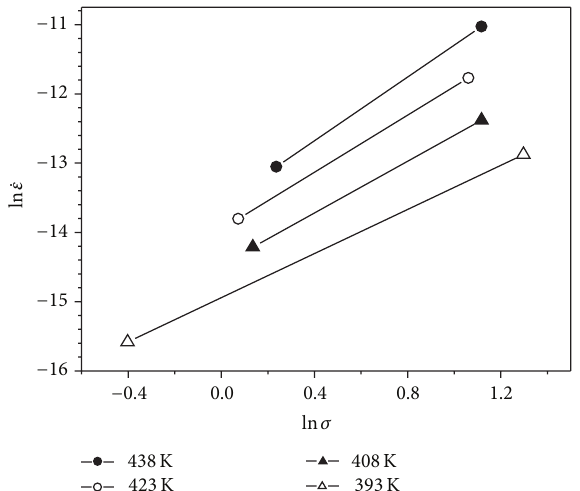
Figure 9: Correlation between strain rate and temperature in the tensile creep